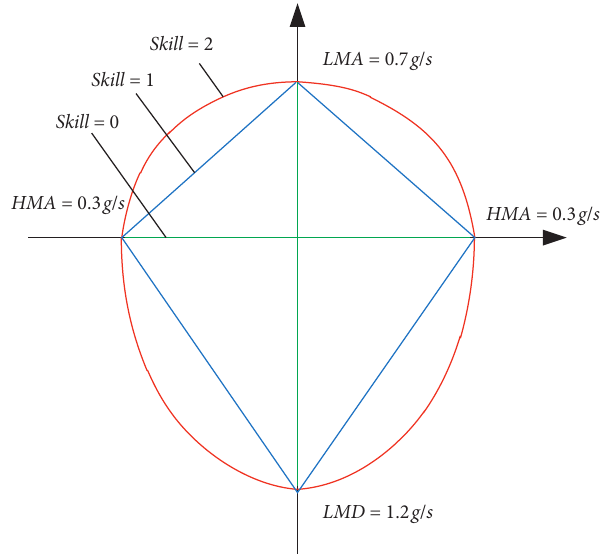
Figure 5: The driver’s microscopic control